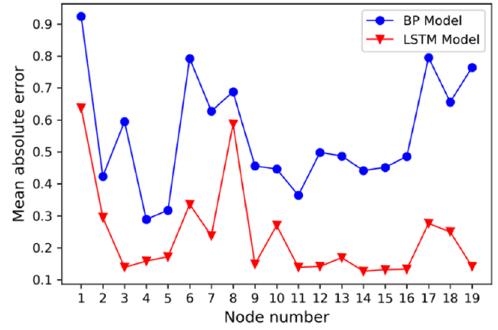
Figure 12. Model error comparison.